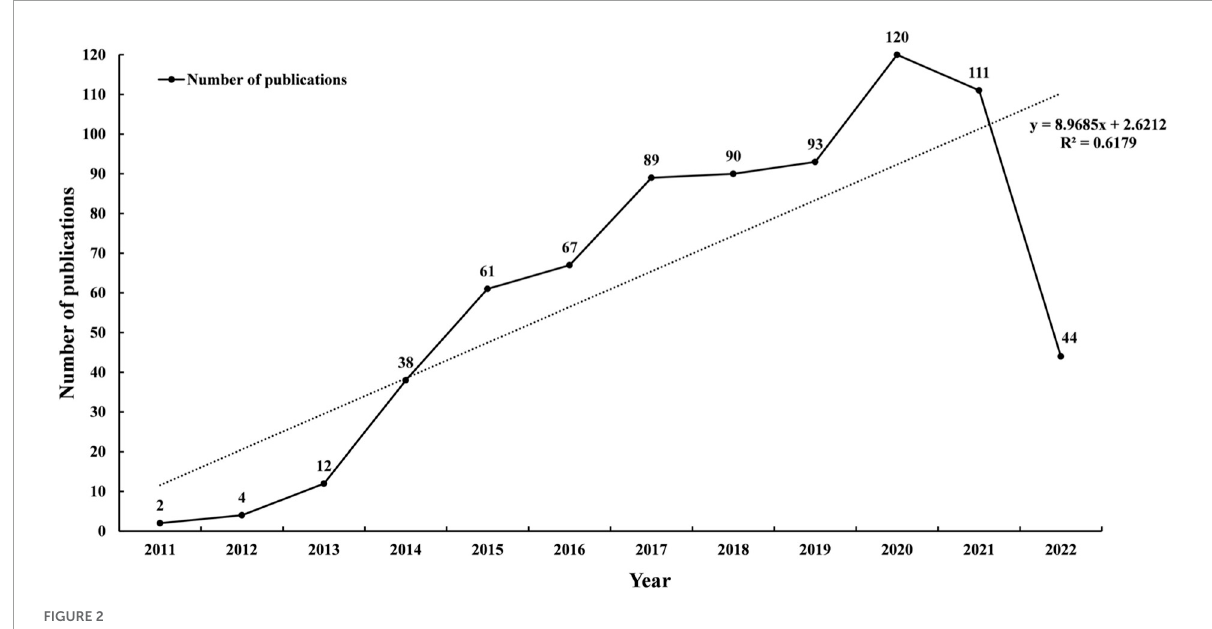
FIGURE2 The number of publications per year (2011–2022).